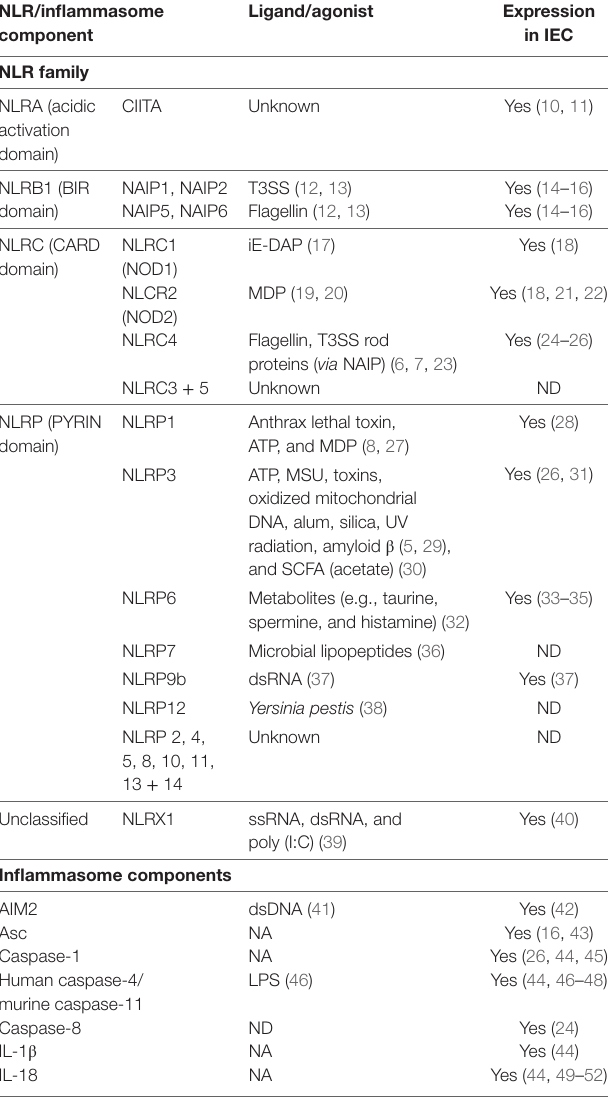
TabLe 1 | NLR family members and other inflammasome